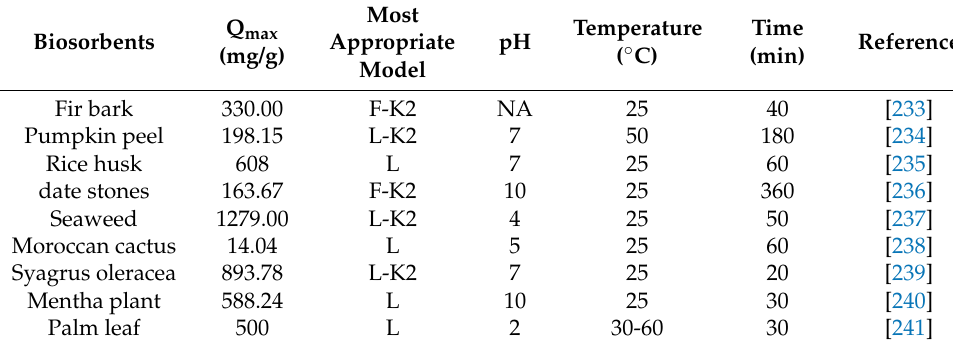
Table 11. Summary of bio-waste-derived adsorbent studies in 2019.